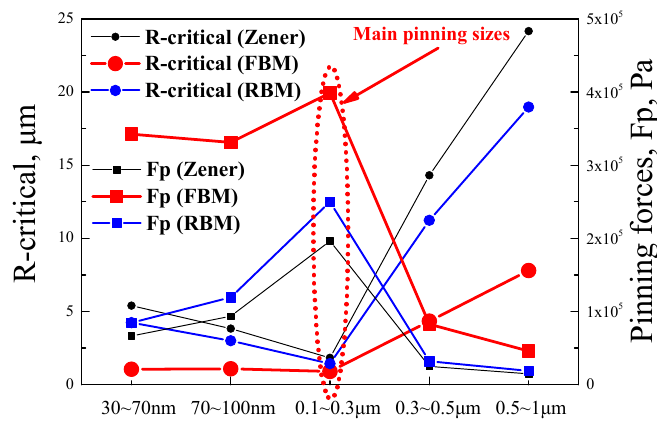
Figure 12. Relationship between Fd and R-critical.